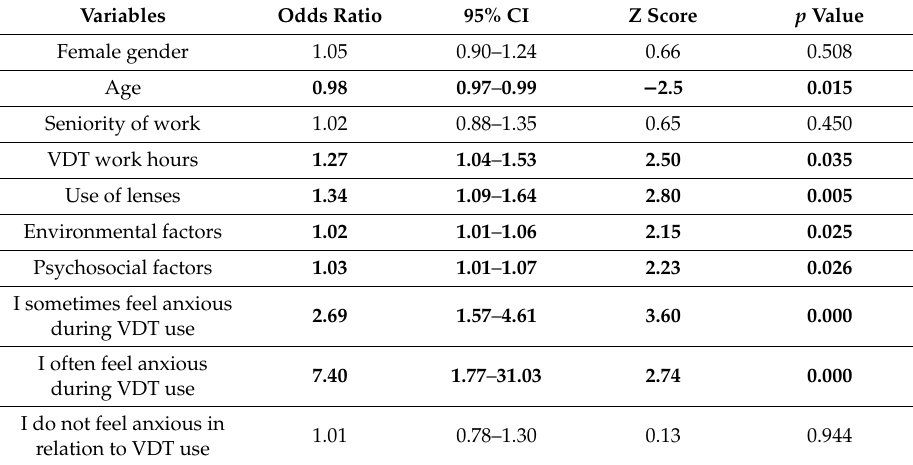
Table 6. Factors associated to visual fatigue during 10-year follow-up using the generalized estimating equation (2208 workers that repeated medical examinations 3 times were included in the